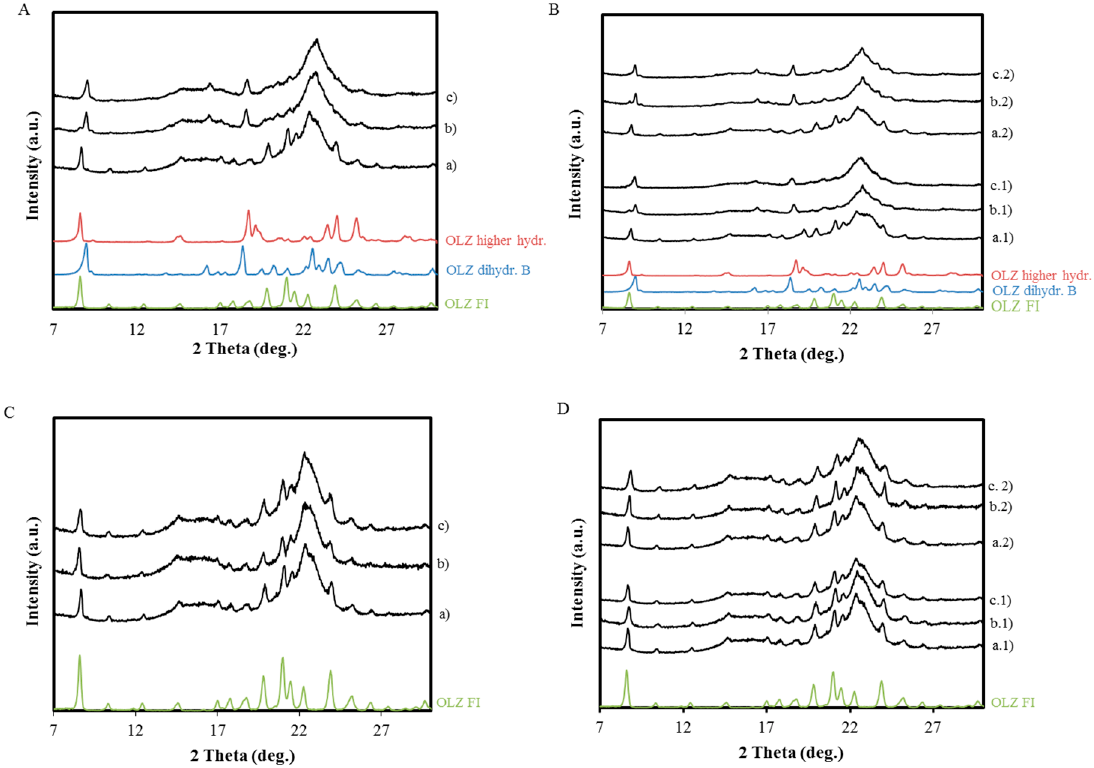
Figure 7. Diffractograms of formulations as physical mixtures (a), as wet masses ( t = 360 min), (b) and